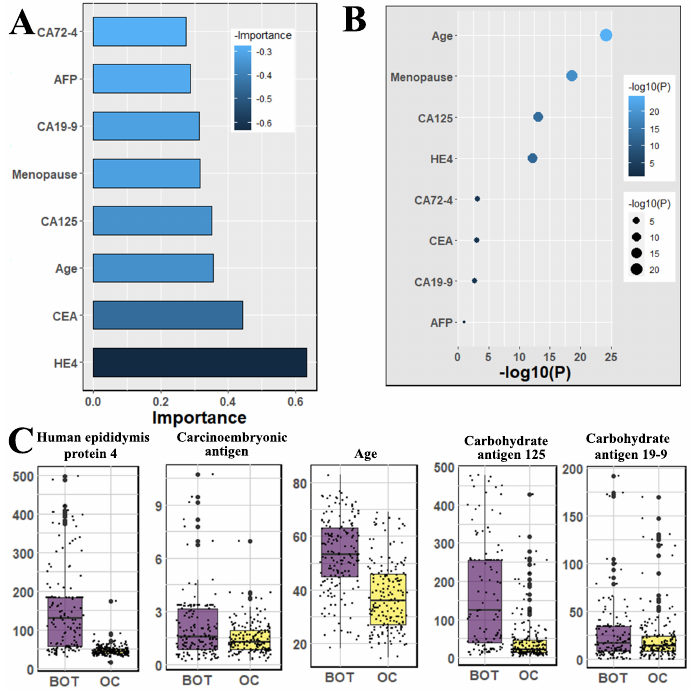
Figure 4. The analysis results for the dataset cancer markers; ( A ) The feature importance of cancer markers calculated by ML algorithms according to coefficient values after model training; ( B ) The association between benign ovarian tumor and ovarian cancer patients applying independent sample t -test, the lighter and larger bubble represent higher association; ( C ) The box plot of the four top most associated cancer markers with patients